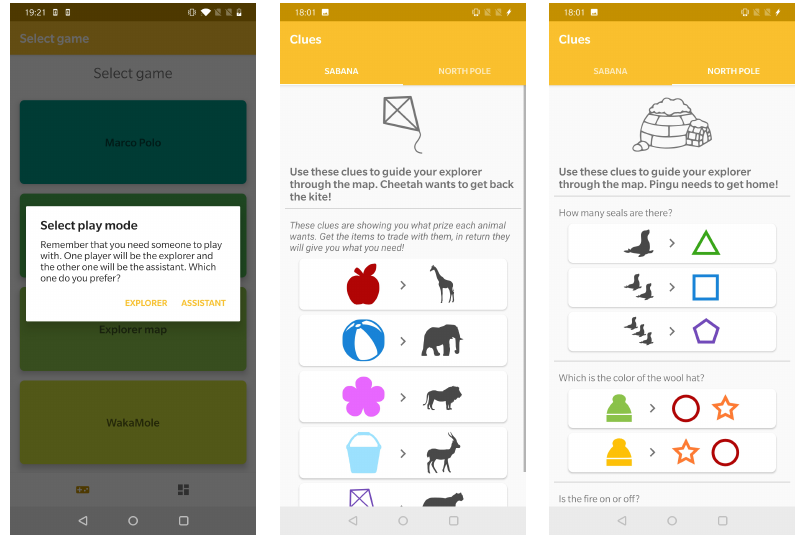
Figure 11. Overview of the “MapAssistant” activity.